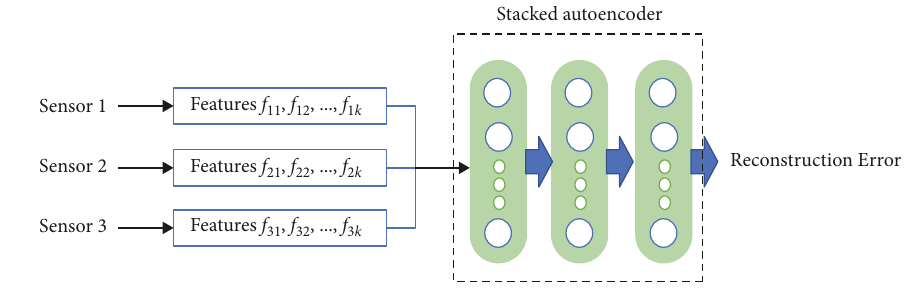
Figure 2: Data fusion anomaly detection scheme.